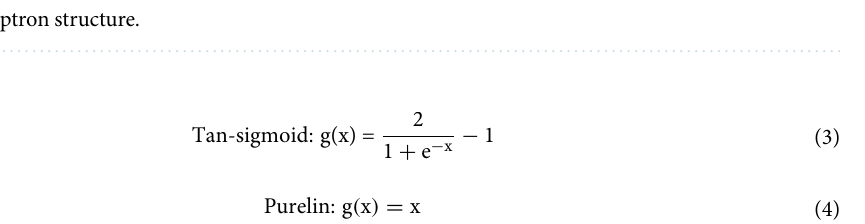
Figure 10. Perceptron